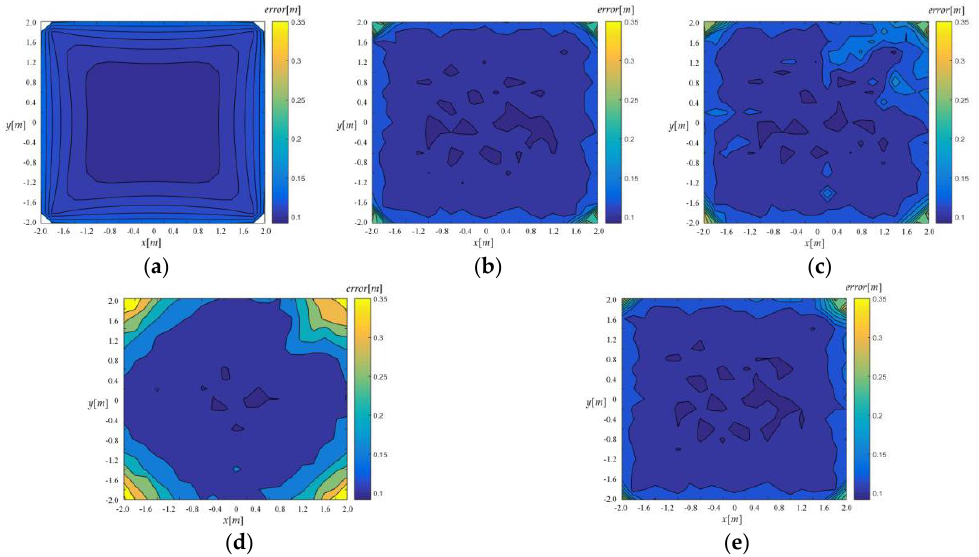
Figure 11. RMSE distribution, σ = 0.1 m. ( a ) CRLB, ( b ) Taylor, ( c ) Jεa -based-FoPC, ( d ) Jεe -based-FoPC,